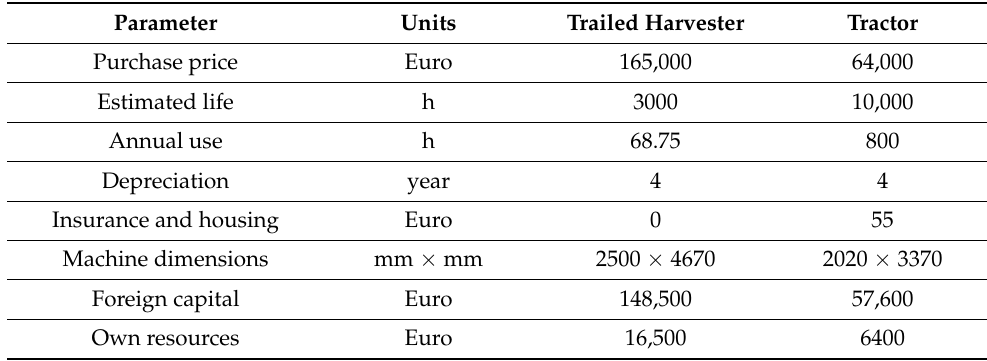
Table 4. Machinery cost